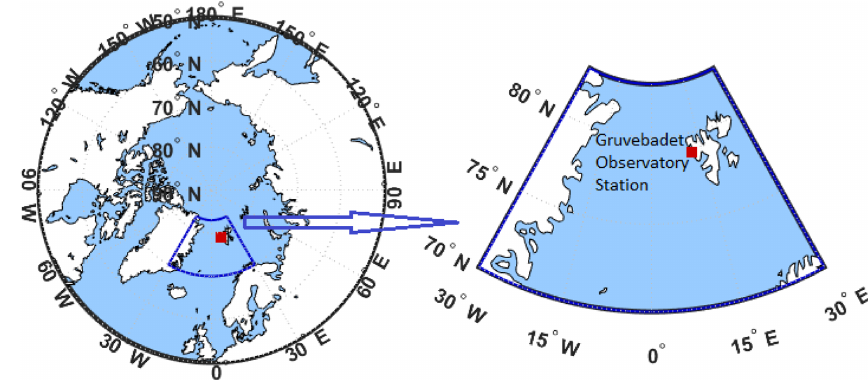
Figure 1. Geographic location of the sampling station, Gruvebadet observatory at Ny-Ålesund, Svalbard islands.